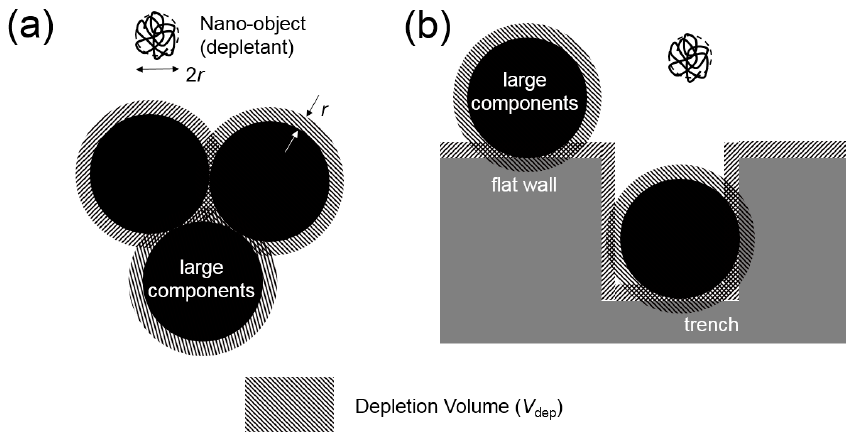
Figure 1. Schematic representation of the depletion volume effect. ( a ) Aggregation of spherical beads. ( b ) Attachment on flat surface (left) and confinement in the trench (right) of beads. Nano-objects (depletants) are present in abundance in the surrounding medium, but only one is depicted in the figure.